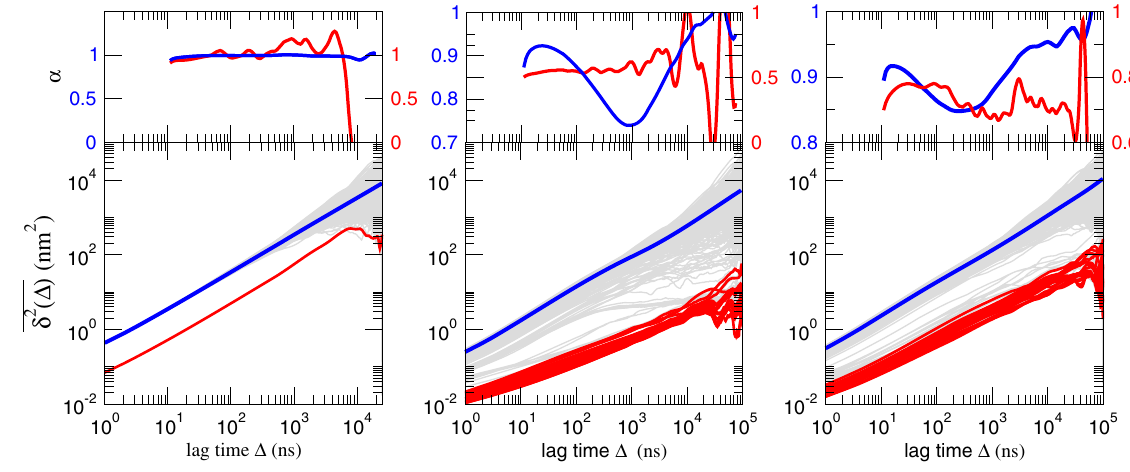
FIG. 2. Time-averaged MSD traces δ 2 ð Δ Þ for both individual lipids (gray thin lines) and NaK proteins (red thick lines) in protein-poor DPPC (left), protein-rich DPPC (middle), and protein-rich DLPC (right) membranes. In each panel, the blue thick line represents the mean time-averaged MSD h δ 2 ð Δ Þi for all lipids in the membrane. The upper panels represent the variation of the scaling exponent α versus the lag time Δ for lipids (blue line) and proteins (red line) in each membrane system from fits to the corresponding mean time- averaged MSDs. In this plot, the offset Δ ¼ 10 ns is due to the finite interval in fitting the instantaneous slope of the time-averaged MSD. Note the different scales of the ordinates in the different panels. We check that the change of the fit range does not seriously alter the α ð Δ Þ curves. Note that, in general, the scaling exponents α of the proteins exhibit larger fluctuation than those of the lipids. In particular, its sudden decrease for Δ > 5 μ s shown in the noncrowded membrane reflects the statistically insignificant fluctuation of a single time-averaged MSD